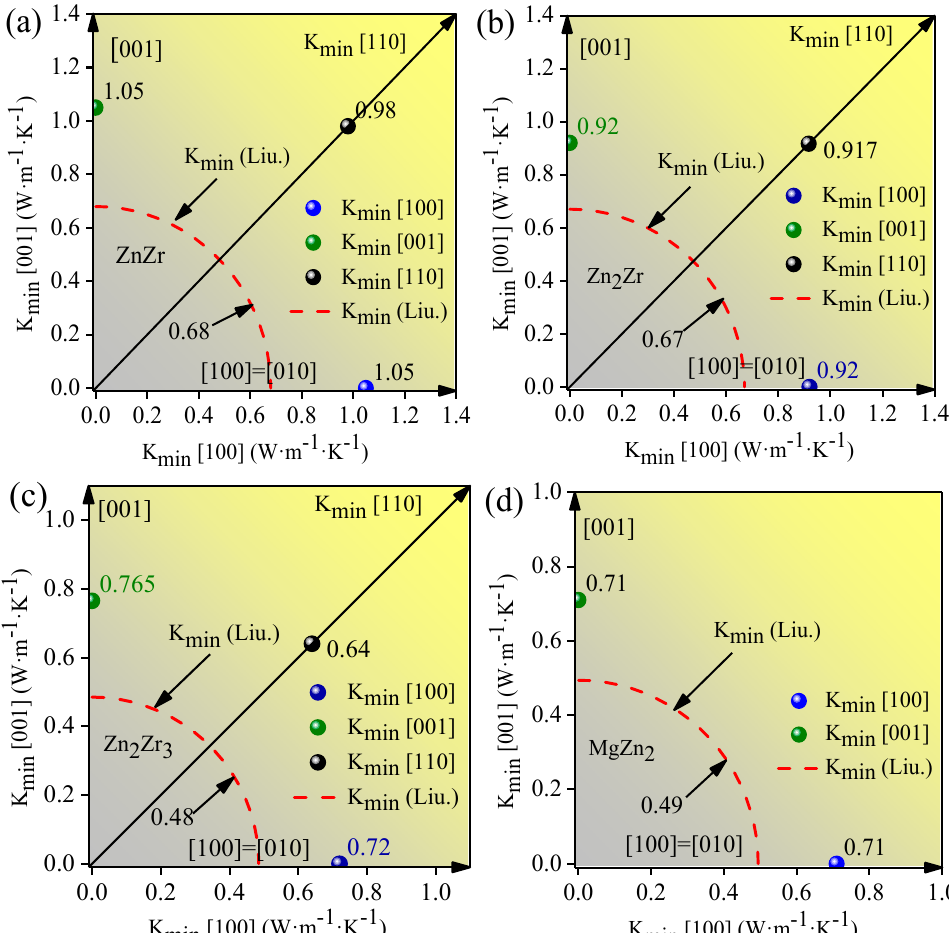
Figure 5. The minimum thermal conductivities along different principal directions of alloys, evaluated using Cahill’s equation and Liu’s model. ( a ) ZnZr; ( b ) Zn 2 Zr; ( c ) Zn 2 Zr 3 and ( d ) MgZn 2 .